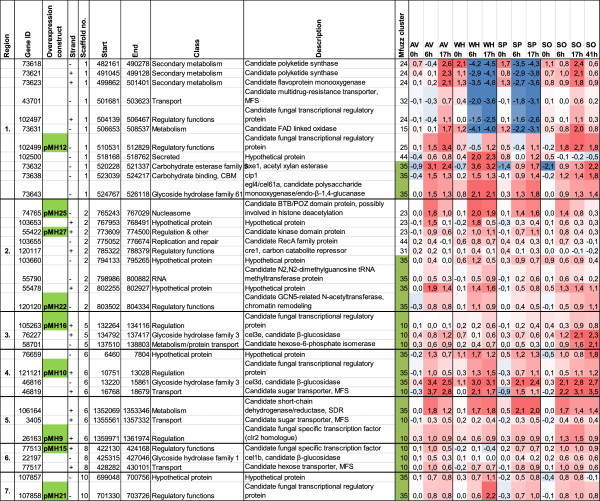
Tightly co-expressed genomic regions with candidate regulatory genes. The expression array dataset described in [8] was searched for genomic regions with co-expressed genes. The regions containing a selected candidate regulatory gene with adjacent genes belonging to the same Mfuzz gene expression clusters as the major cellulase and hemicellulase genes are shown. The genomic location of the genes is indicated as scaffold number, start and end position, and strand in the scaffold as in T. reesei database 2.0 [45]. Gene annotation is as in T. reesei database 2.0. The expression data of the genes in the induction dataset with cellulose, wheat and spruce material, and sophorose is shown as the expression cluster number (Mfuzz) and fold change of the transcript signals in the induced cultures as compared to the uninduced control cultures at the same time point. The intensity of the red color and blue color indicates the strength of positive and negative fold changes as compared to the uninduced control cultures, respectively. AV, Avicel cellulose; SO, sophorose; SP, spruce; WH, wheat straw.